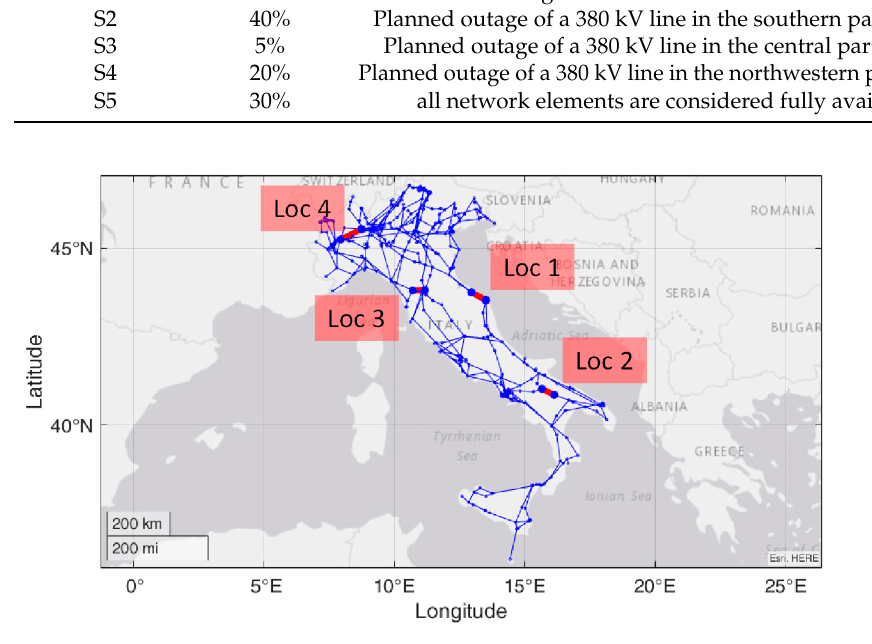
Figure 2. Location of the planned maintenance cases.